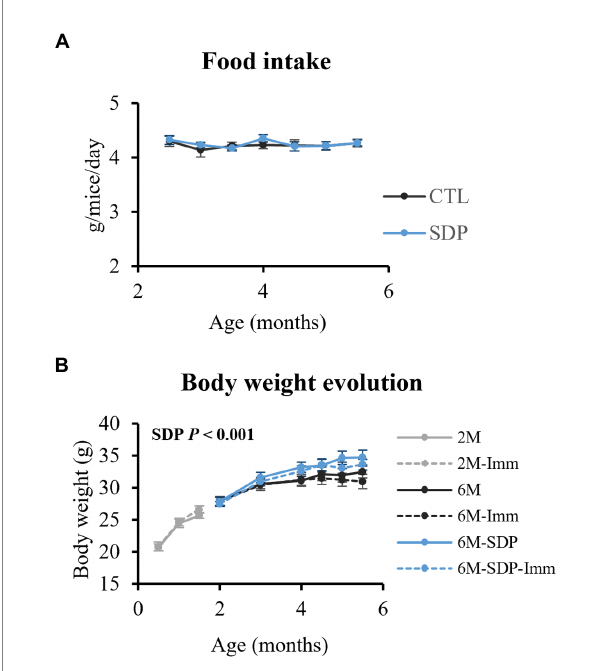
FIGURE 2 Food intake (A) and changes over time in body weight (B) . Results are expressed as means ± SEMs ( n = 18–20 animals for food intake and n = 9–10 animals for changes in body weight). Statistics: for food intake, two-way ANOVA (feed and time; Fisher multiple comparison test); changes over time in body weight, three-way ANOVA (feed, immunization, and time; Fisher multiple comparison test). Imm, immunized mice; Non-Imm, non-immunized mice; SDP, spray-dried porcine